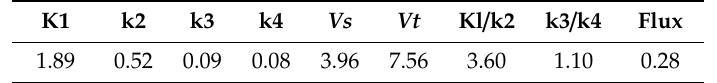
Table1. Two-tissuecompartmentmodelingparametersforthedatashowninFigure3usingEquation(1).